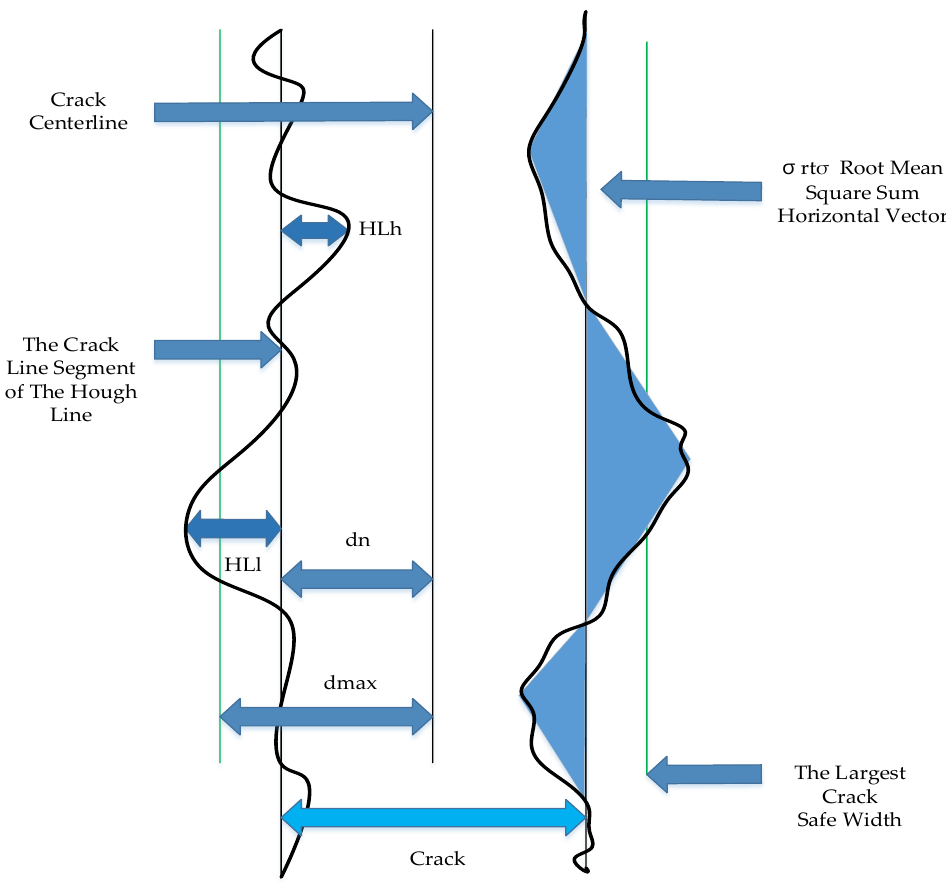
Figure 7. Schematic diagram of the GHEM.